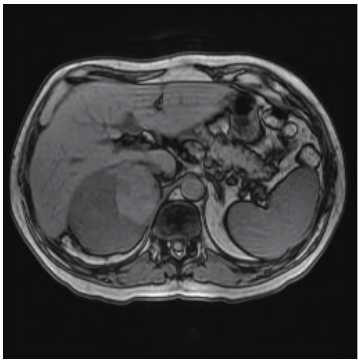
Figure 1: CT scan showing 11.3cm × 9.7 cm right adrenal mass with scattered calcifications.